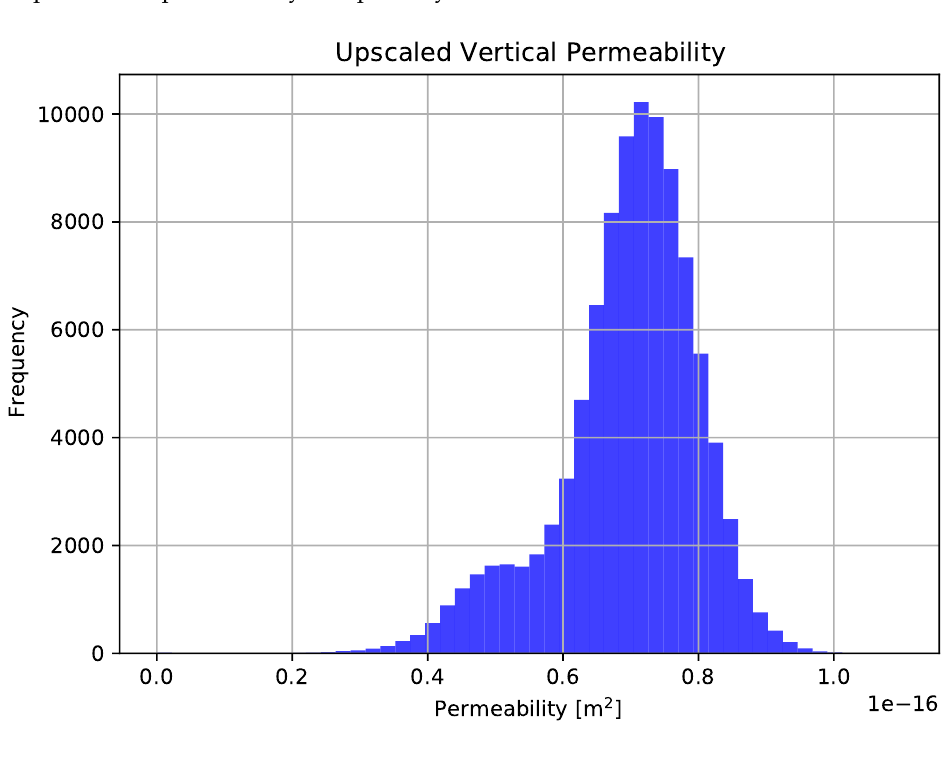
Figure 8. Upscaled vertical permeability values for the FORGE reference DFN model generated using a log-normal fracture size